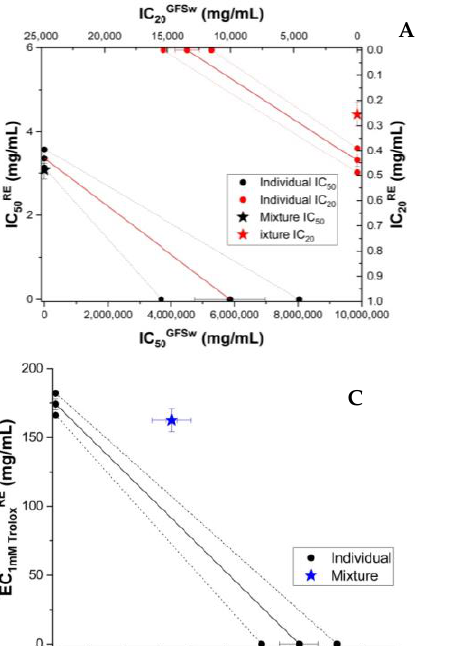
Figure 8. X-ray diffractograms of honey (red) and GFSw (black).